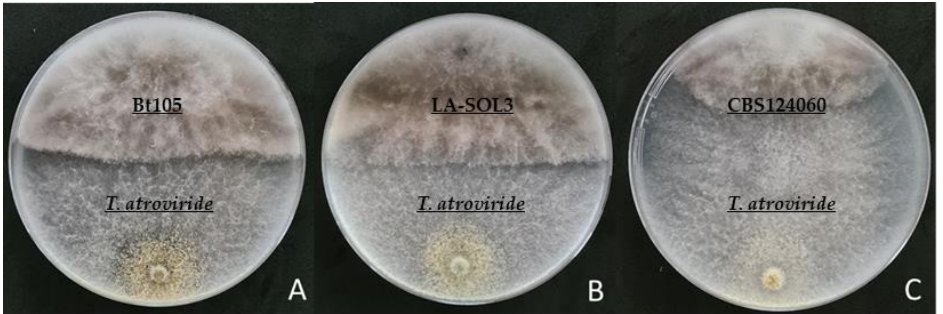
Figure 2. Dual culture antagonism assay of T. atroviride strain I-1237 and the three Lasiodiplodia spp. isolates under study. A : isolate Bt105; B : isolate LA-SOL3; C : isolate CBS124060.